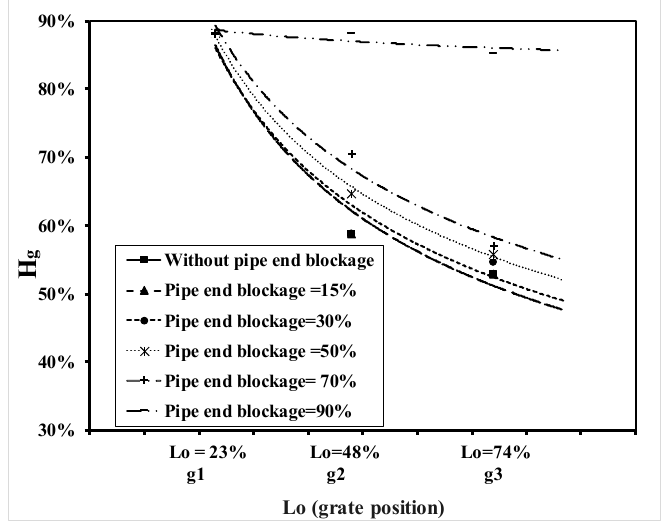
Figure 11. Relationship between Hg and LO for different relative blockage heights at Q = 1.20L/sec.